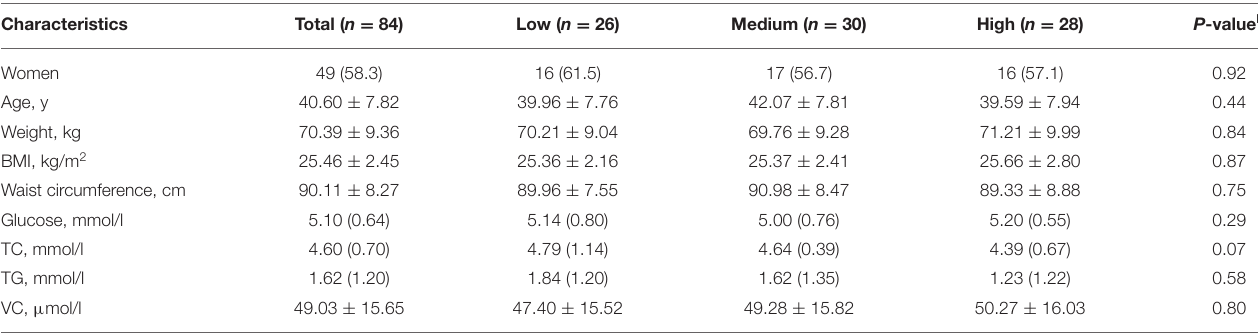
TABLE 1 | Baseline characteristics of participants a .